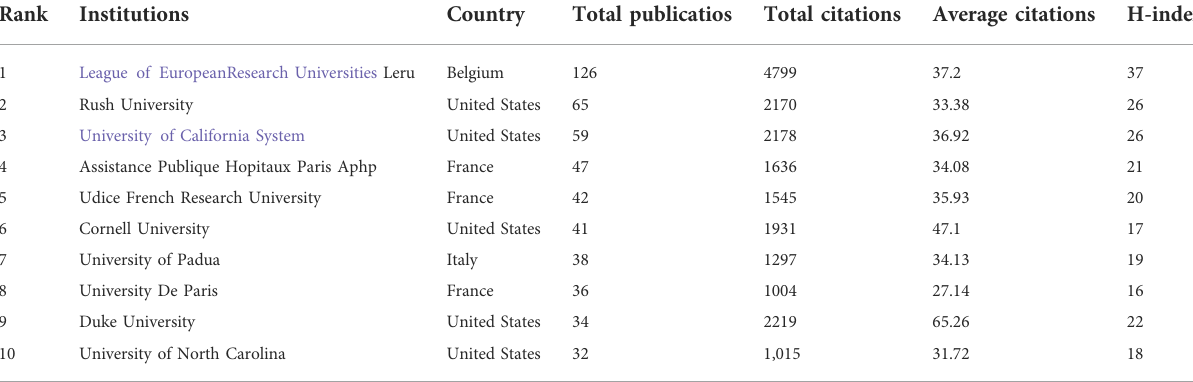
TABLE 2 The top ten institutions that contributed publications on HA for the treatment of osteoarthritis.